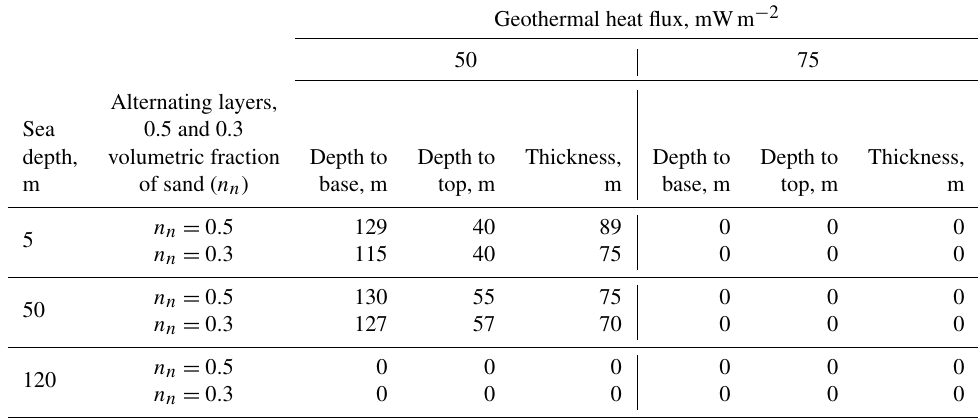
Table 4. Modeling results for depths to permafrost top and base and permafrost thickness for 50m of alternating sand and clayey silt (clay) layers lying over bedrock, SW area.